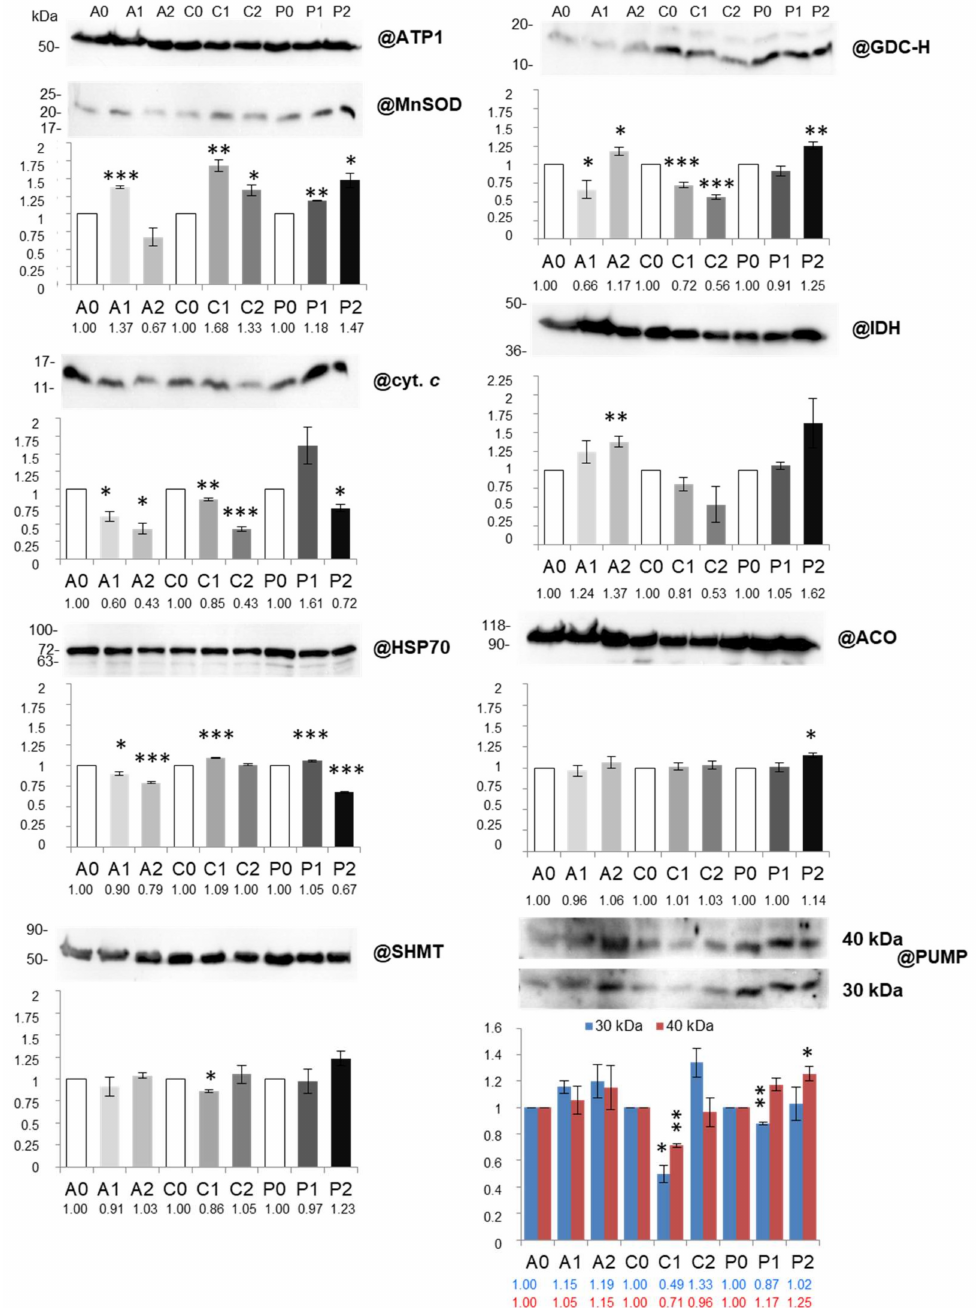
Figure 3. Abundance of Mn-superoxide dismutase (@MnSOD), cytochrome c (@cyt. c ), heat shock protein 70 (@HSP70), serine hydroxymethyltransferase (@SHMT), glycine decarboxylase subunit H (@GDC-H), isocitrate dehydrogenase (@IDH), aconitase (@ACO) and 40 and 30kDa isoforms of uncoupling proteins (@PUMP) in mitochondria isolated from control grown “ Adelanto ”, “ Casper ”, and “ Pionier ” plants (A0, C0, P0), plants grown in moderate (A1, C1, P1) and severe water deficiency (A2, C2, P2, respectively). Results from representative SDS-polyacrylamide gel blots using listed antibodies (@) are shown. For loading control, antibody against mitochondrial ATP synthase subunit α (@ATP1) is used. For molecular mass calibration, PageRuler Prestained Protein Ladder (Thermo Scientific, Gda´nsk, Poland) is applied. Protein molecular mass is indicated in kDa. All results are presented as mean values ( ± SE) from triplicate detection. Significant alterations are marked with asterisks: ***, p < 0.001, **, p < 0.01, *, p < 0.05 versus control values for each cultivar. Further data in the